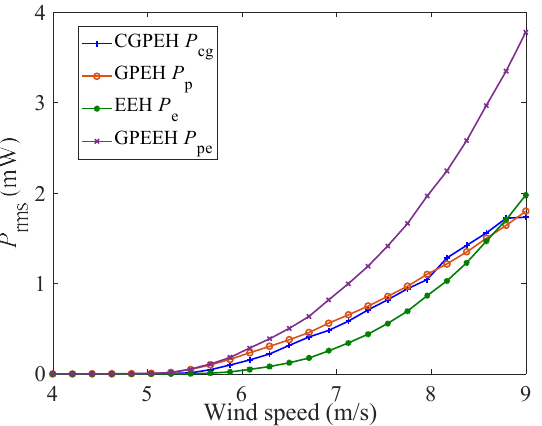
Figure 9. Comparison of effective output power between GPEEH and CGPEH.